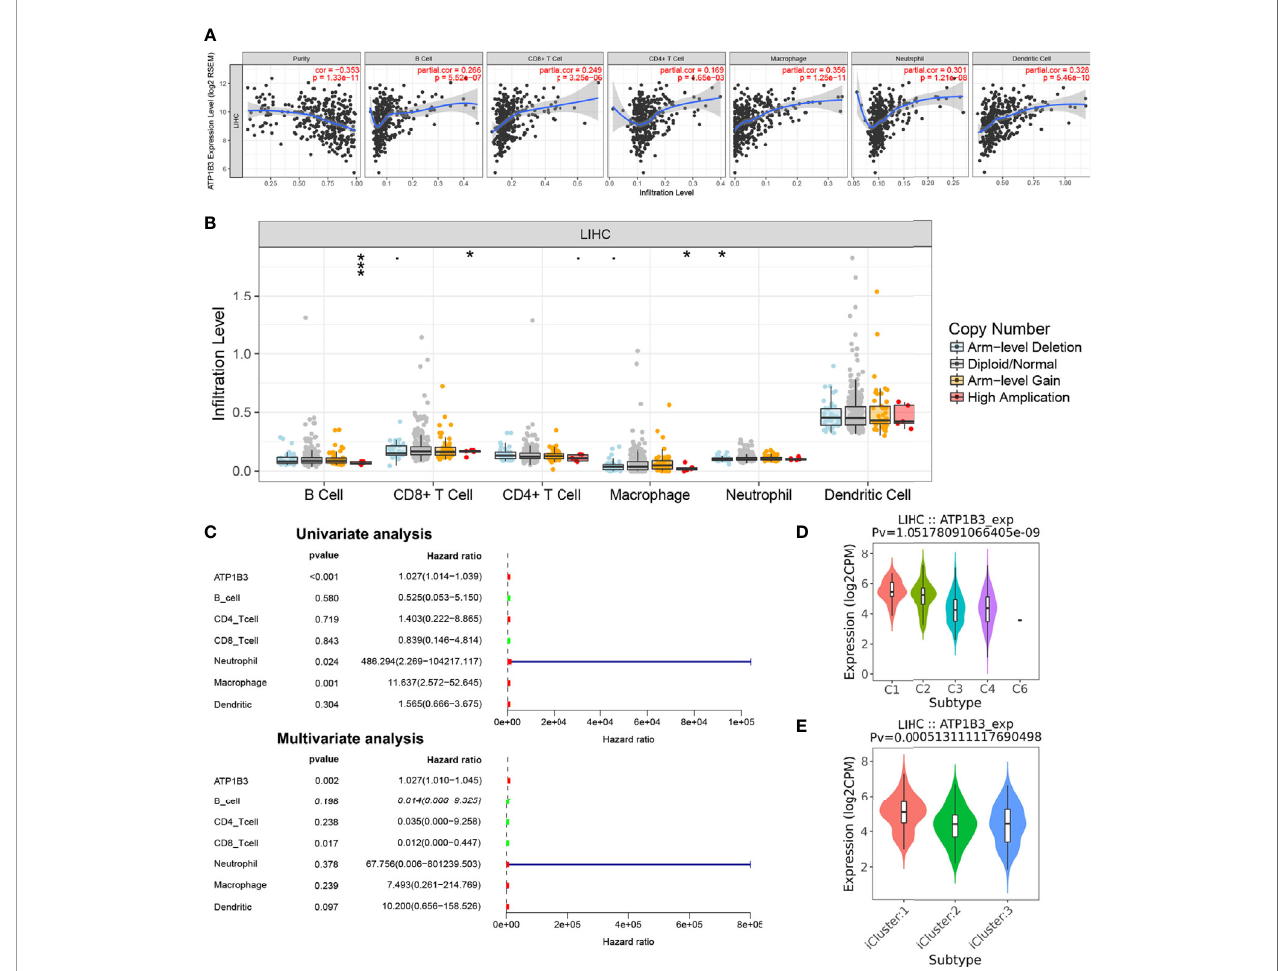
FIGURE 5 | The association of ATP1B3 and immune in fi ltration level in HCC using the TIMER. (A) The correlation between ATP1B3 expression level and immune in fi ltration. (B) The relationship between ATP1B3 CNV and immune in fi ltration. * p < 0.05, ** p < 0.01, *** p < 0.001. (C) The prognosis of ATP1B3 and immune cells for OS of HCC. (D) Associations between ATP1B3 expression and immune subtypes in HCC. C1 (wound healing); C2 (IFN-gamma dominant); C3 (in fl ammatory); C4 (lymphocyte depleted); C5 (immunologically quiet); C6 (TGF-b dominant). (E) Associations between ATP1B3 expression and molecular subtypes in